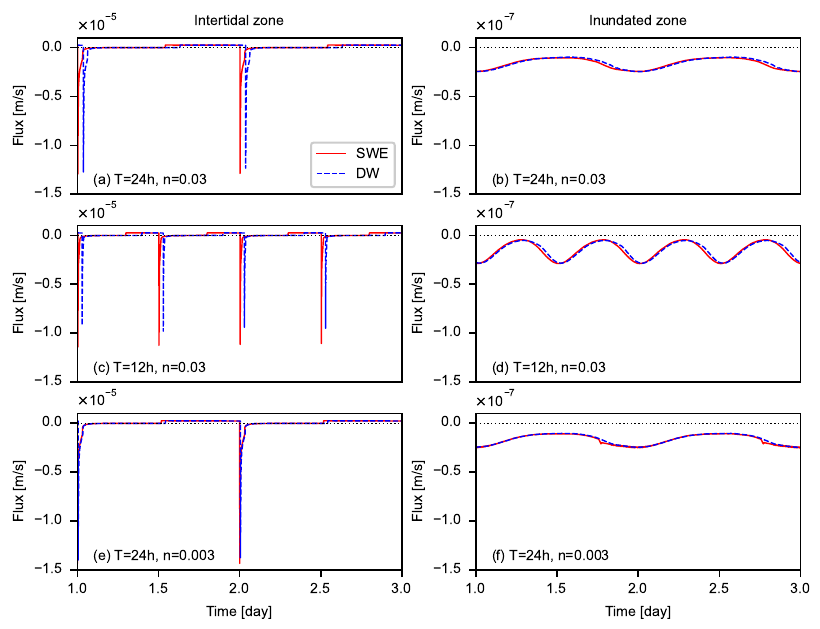
Figure 10. Surface-subsurface exchange flux for simulations of inundation of an intertidal zone as measured at the 1/2 location (left column) and 3/4 location (right column) noted in Figure 6. Negative flux represents infiltration. The output interval is 20 s. The black dotted line represents zero